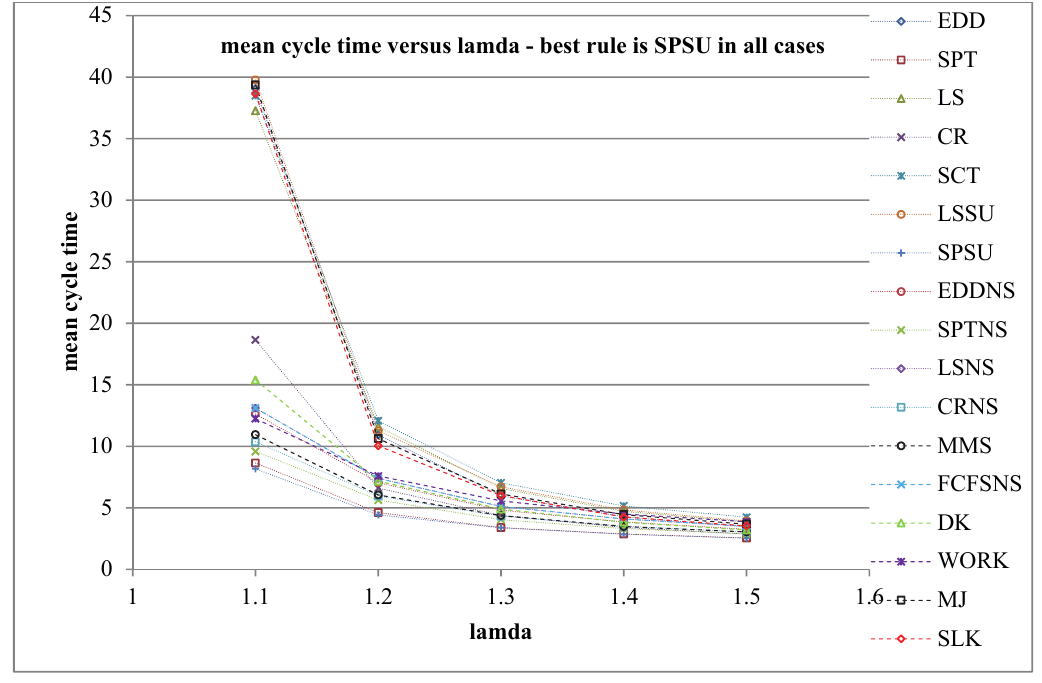
Fig. 2. Mean cycle time for simulation cases 1 – 5